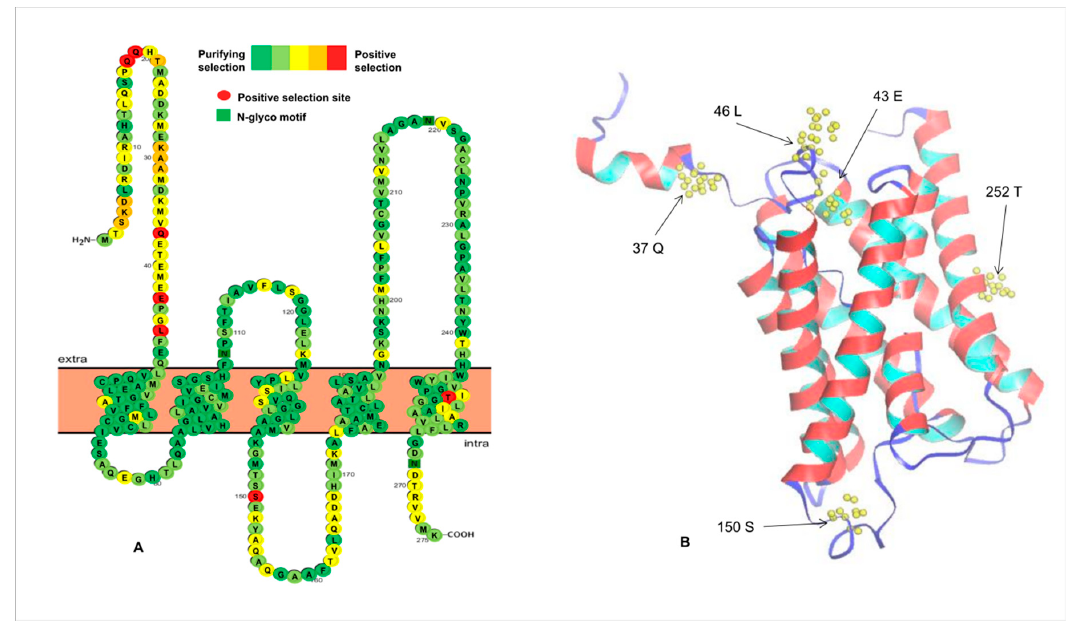
Figure 4. Distribution of PSS of the Group III Aqp members predicted by the M8 model. The secondary structure ( A ) and the tertiary structure ( B ) of the Dre_aqp8b protein are shown here, respectively. Since the signal peptide sequence did not appear in the three-dimensional structure of this protein, the two positive selection sites (18Q and 19Q) thereon are not labeled here.